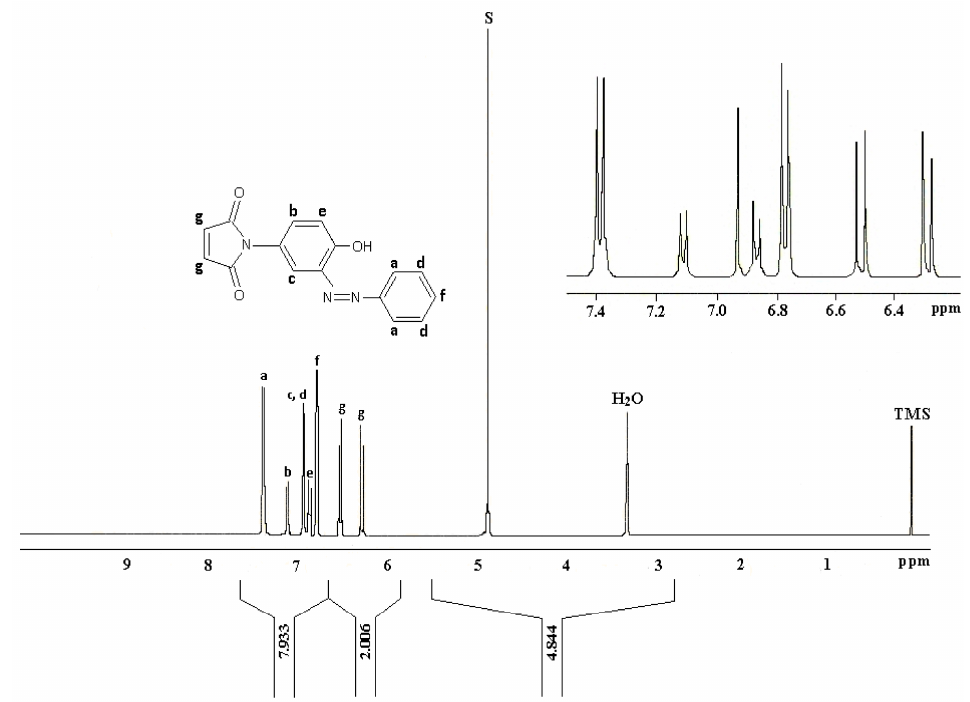
Figure 7. Proton NMR of phenylazo-3- N -(4-hydroxyphenyl)maleimide ( 1 ) in CD 3 OD as reported in [1].